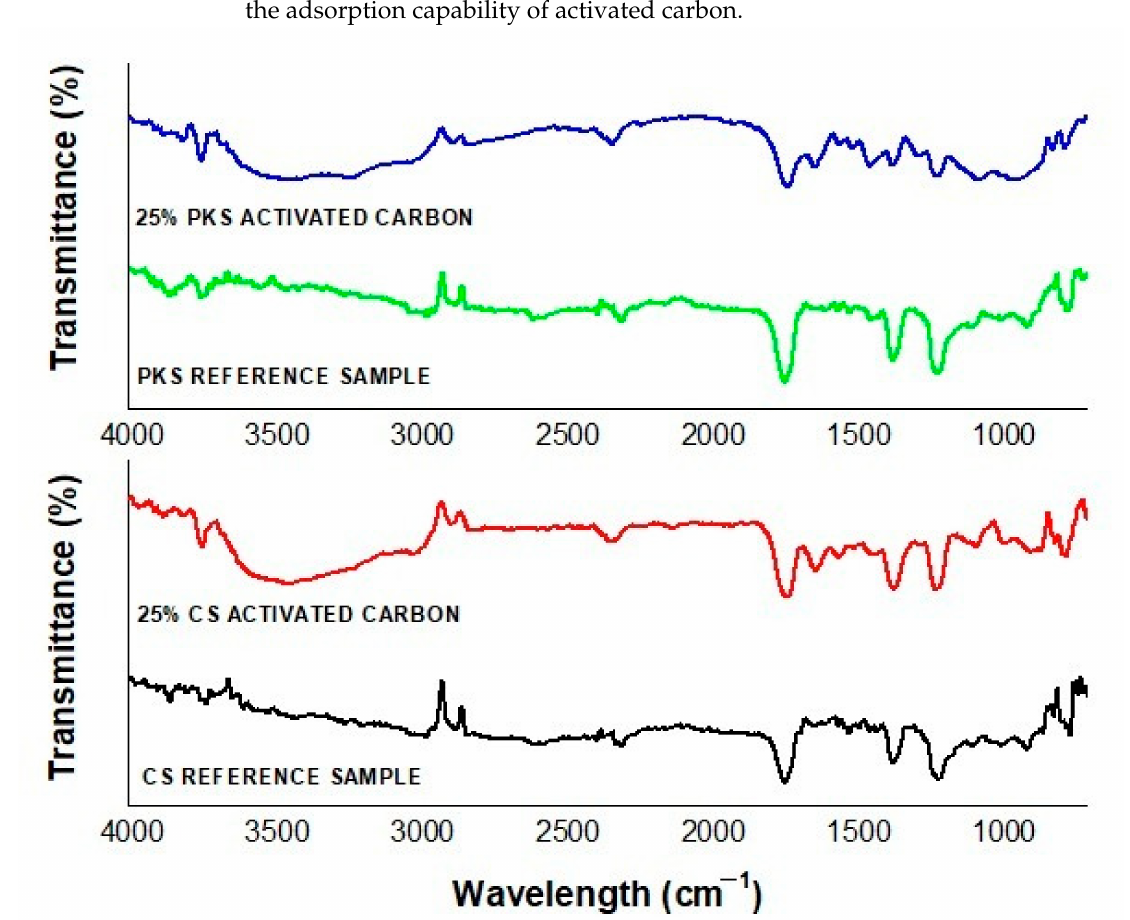
Figure 5. FTIR for CS and PKS activated carbons prepared in 700 ◦ C for 75 min (reference sample) and activated carbon (700 ◦ C, 75 min) post-treated with 25% of